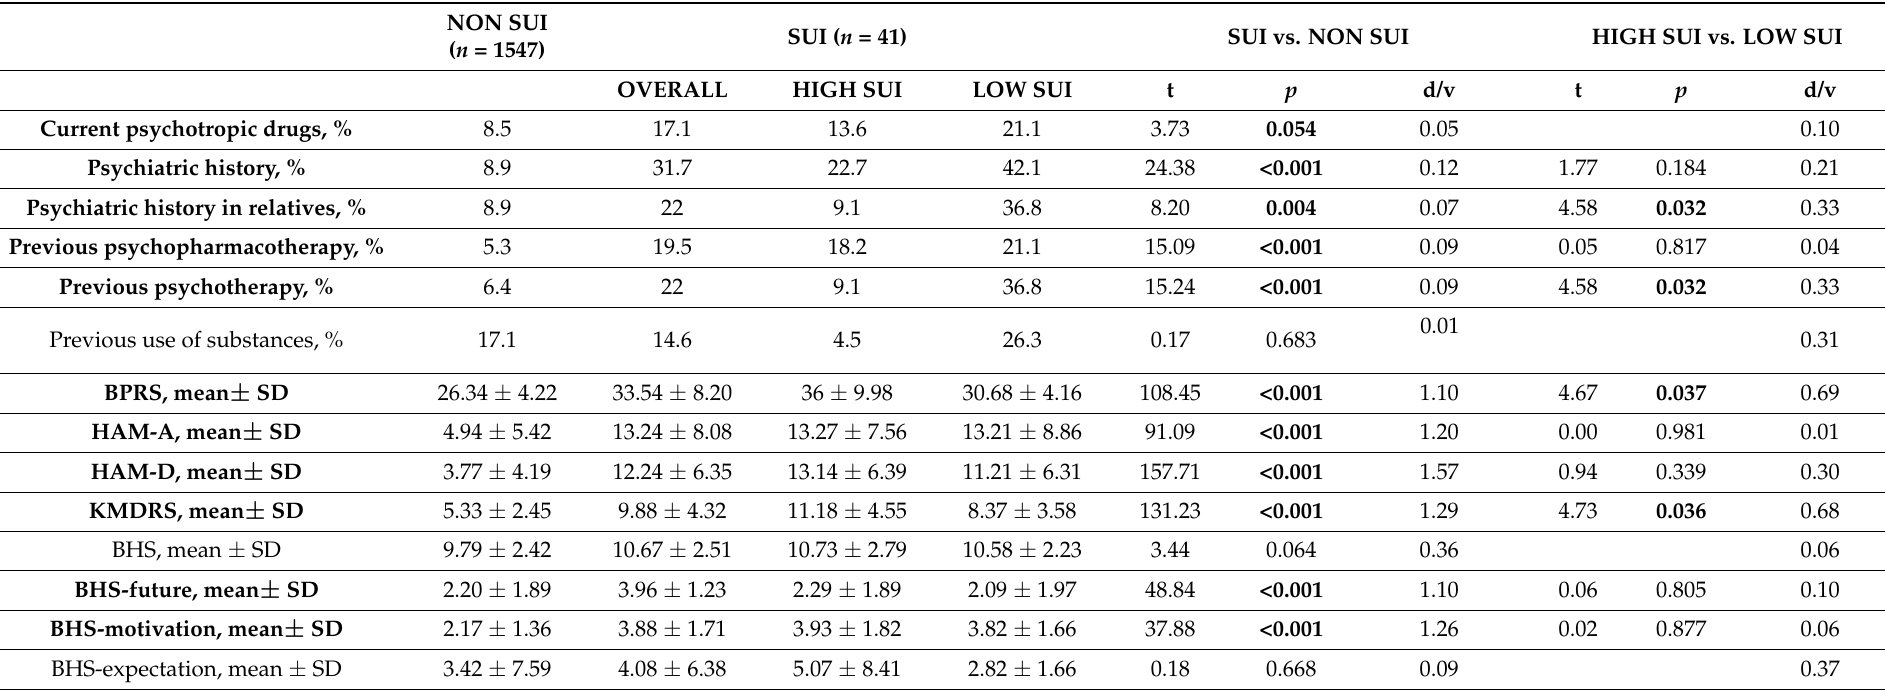
Table 4. Psychopathological characteristics of subjects with SUI, NON SUI, LOW SUI, and HIGH SUI. NON SUI SUI ( n = 41) SUI vs. NON SUI HIGH SUI vs. LOW SUI ( n = 1547) OVERALL HIGH SUI LOW